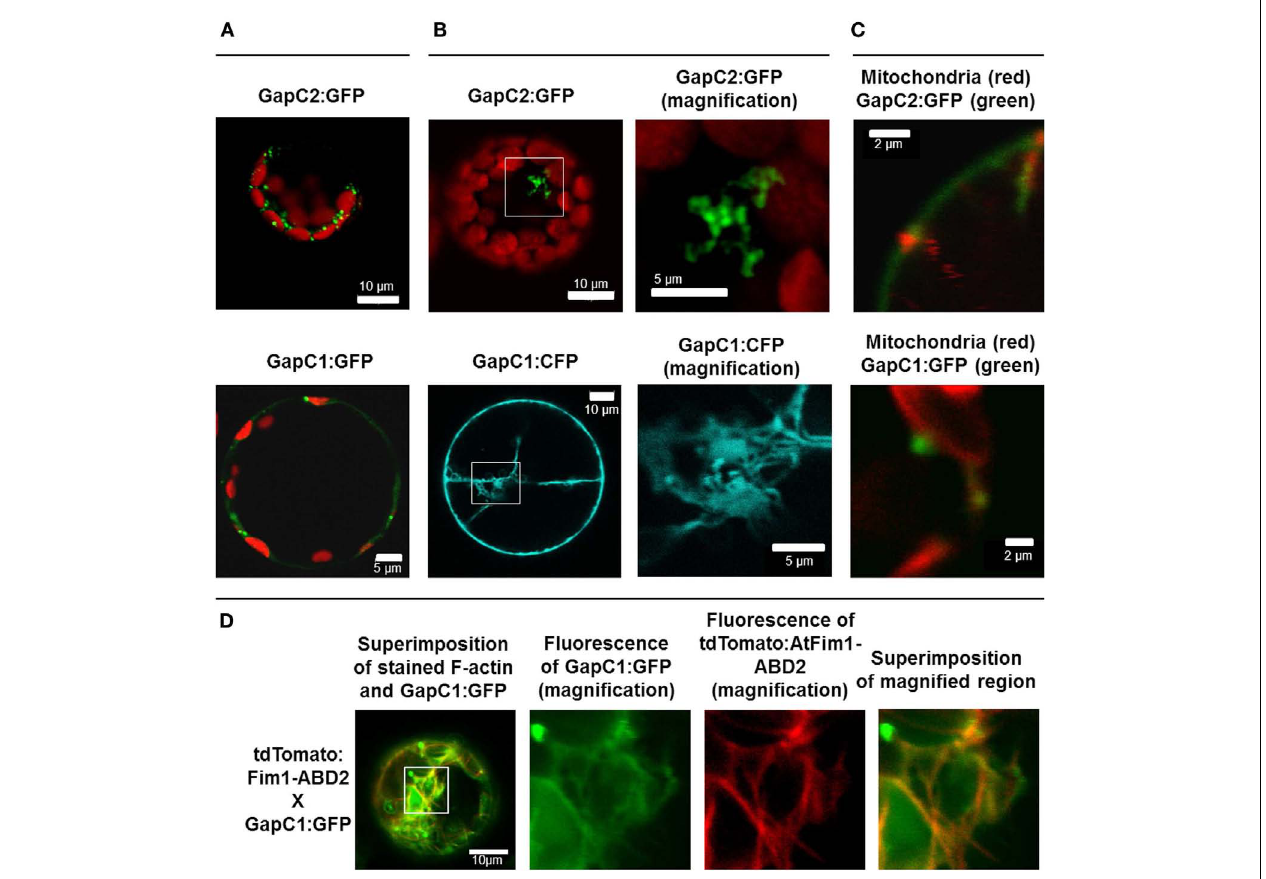
FIGURE 1 | Manifold localization patterns of the GAPDH isoforms. GFP- and CFP fusions of the two isoforms of GAPDH (GapC1 and GapC2) were transiently expressed in the protoplasts, isolated from leaves of 6-week-old plants of A. thaliana . (A) Superimposition of chlorophyll autofluorescence and locally accumulated GFP-fusions of the two isoforms. (B) GFP- and CFP-fluorescence from the GapC1 and GapC2 fusions, respectively. On the right hand side, magnifications are shown of relevant parts. (C) Colocalization of GFP-fused GapC1 and GapC2 with MitoTracker-stained mitochondria.